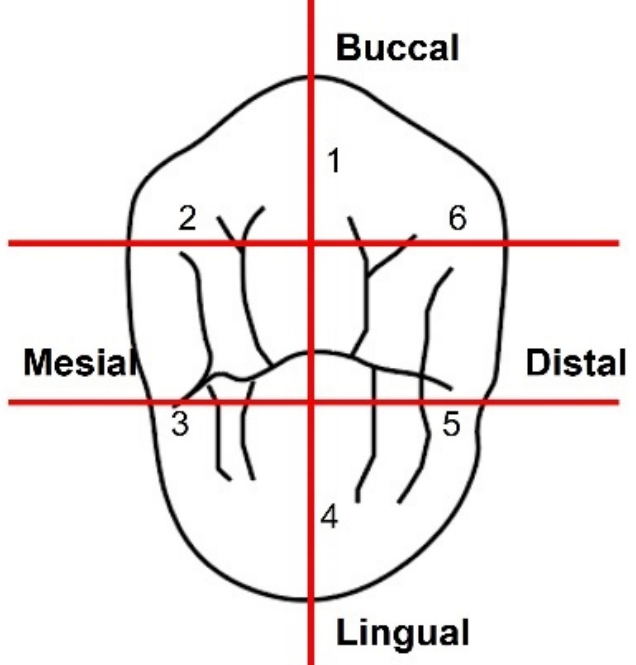
Figure 6. Schematic diagram of the occlusal view of the silicone replica mold showing the pattern of cut sections for IG evaluation: 1.buccal; 2. mesio-buccal; 3. mesio-lingual; 4. lingual; 5. disto-lingual; 6. disto-buccal(indicated through the red lines).